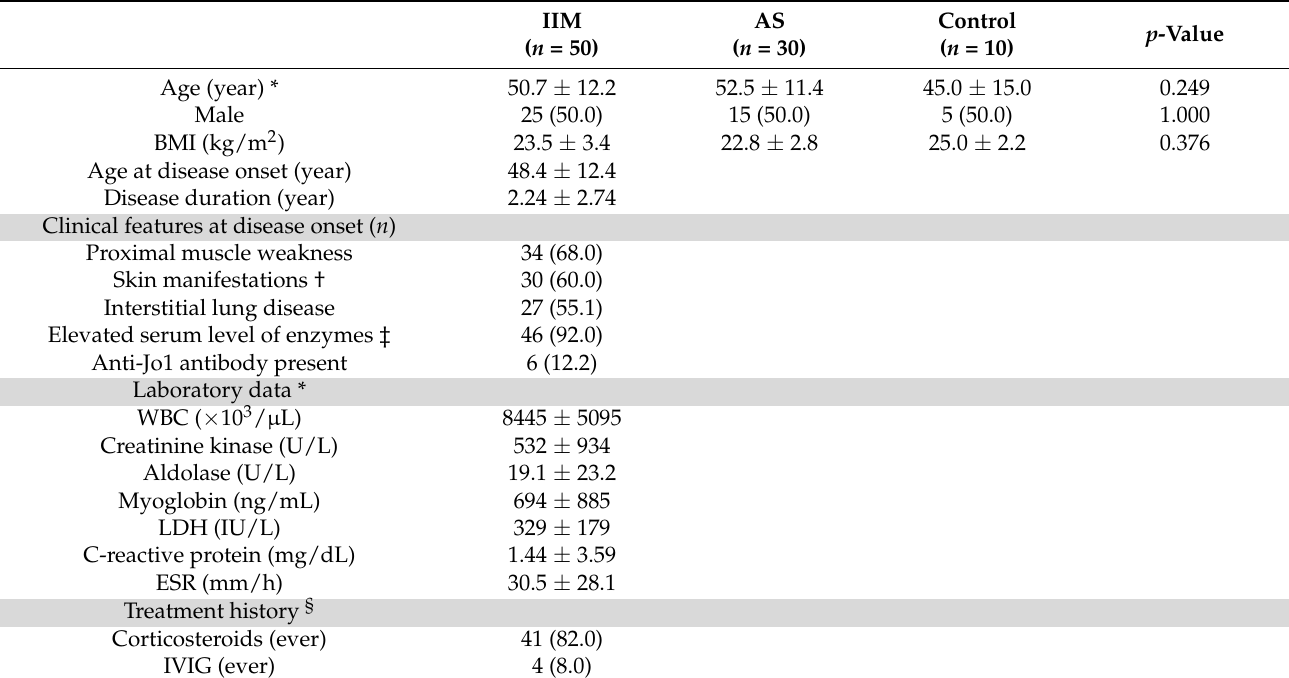
Table 1. Demographics and clinical parameters of study